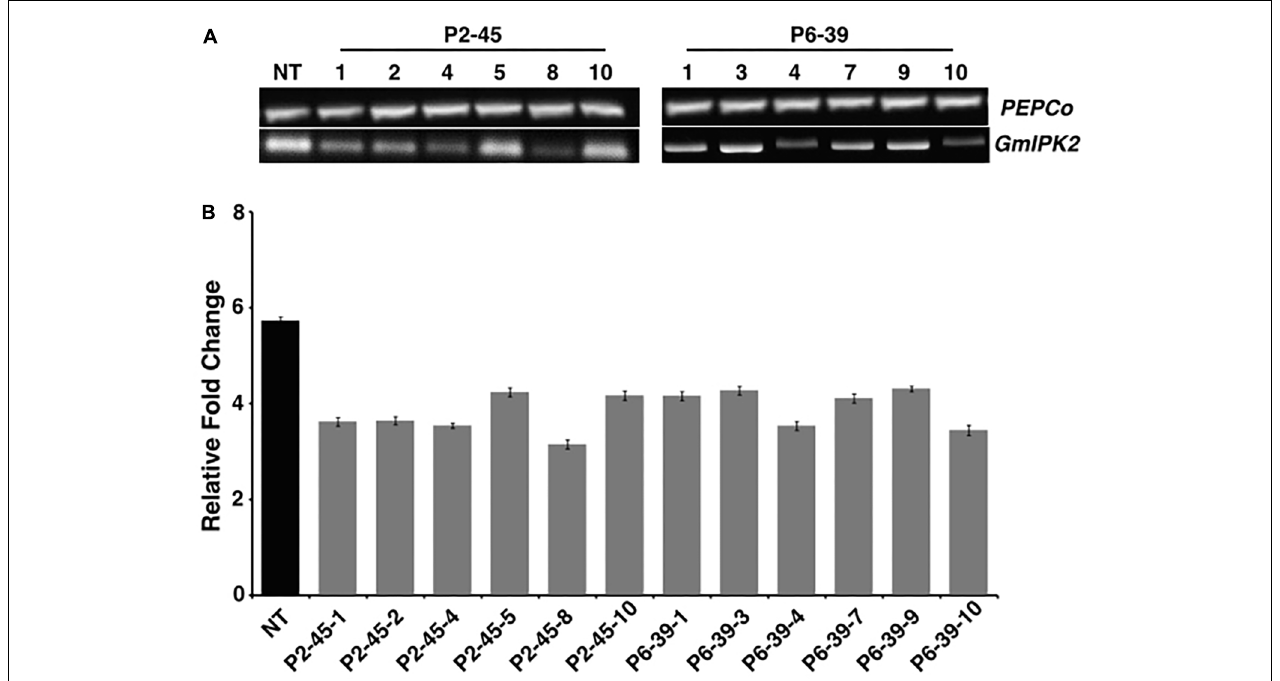
FIGURE 5 | Expression analysis of transgenic soybean seeds. (A) RT-PCR amplification showing variation in GmIPK2 transcripts in T 3 seeds of P2-45 and P6-39 compared to the PEPCo internal control (NT: Non-transformed plant). Representative lanes were spliced from the original gel (Supplementary Figure S2). (B) Relative fold change measured by qRT-PCR in the above samples indicating varied levels of silencing with maximum reduction observed in P2-45-8. The data presented is mean of technical triplicates corresponding to each biological replicate ( n = 3) with error bars indicating standard deviation (SD).